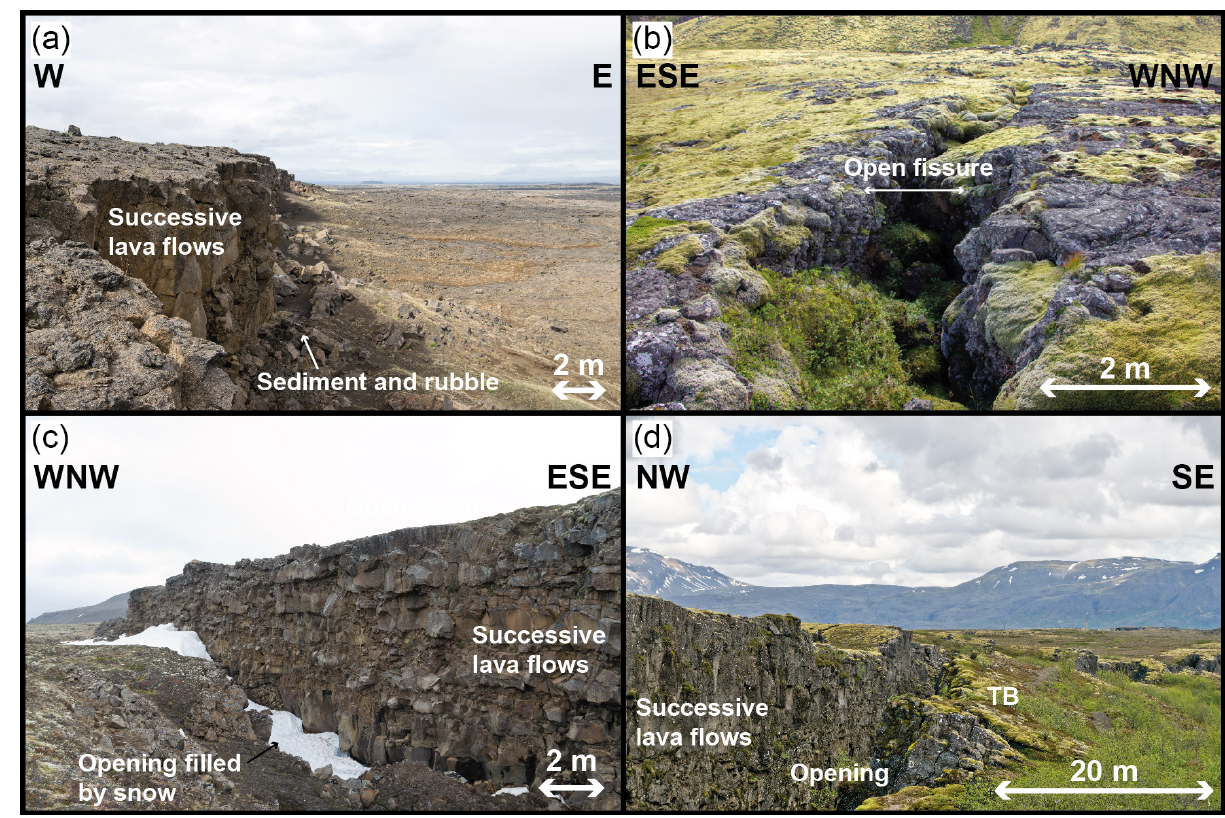
Figure 3. (a) Normal fault with no visible opening width but a clear scarp with vertical offset. Aeolian sediments and rubble form at the bottom of the scarp, forming a colluvial wedge; 65 ◦ 32 (cid:48) 12 (cid:48)(cid:48) N, 16 ◦ 17 (cid:48) 27 (cid:48)(cid:48) W. (b) Fissure with no vertical offset but a prominent opening width; 64 ◦ 00 (cid:48) 11 (cid:48)(cid:48) N, 21 ◦ 43 (cid:48) 20 (cid:48)(cid:48) W. (c) Dilatant fault, combining opening width with vertical offset. The free face of the fracture shows a succession of lava flows; 65 ◦ 48 (cid:48) 43 (cid:48)(cid:48) N, 16 ◦ 44 (cid:48) 3 (cid:48)(cid:48) W. (d) Tilted block on a dilatant fault; note the slope on the right side of the image dipping away from the main fault; 64 ◦ 14 (cid:48) 33 (cid:48)(cid:48) N, 21 ◦ 8 (cid:48) 37 (cid:48)(cid:48)